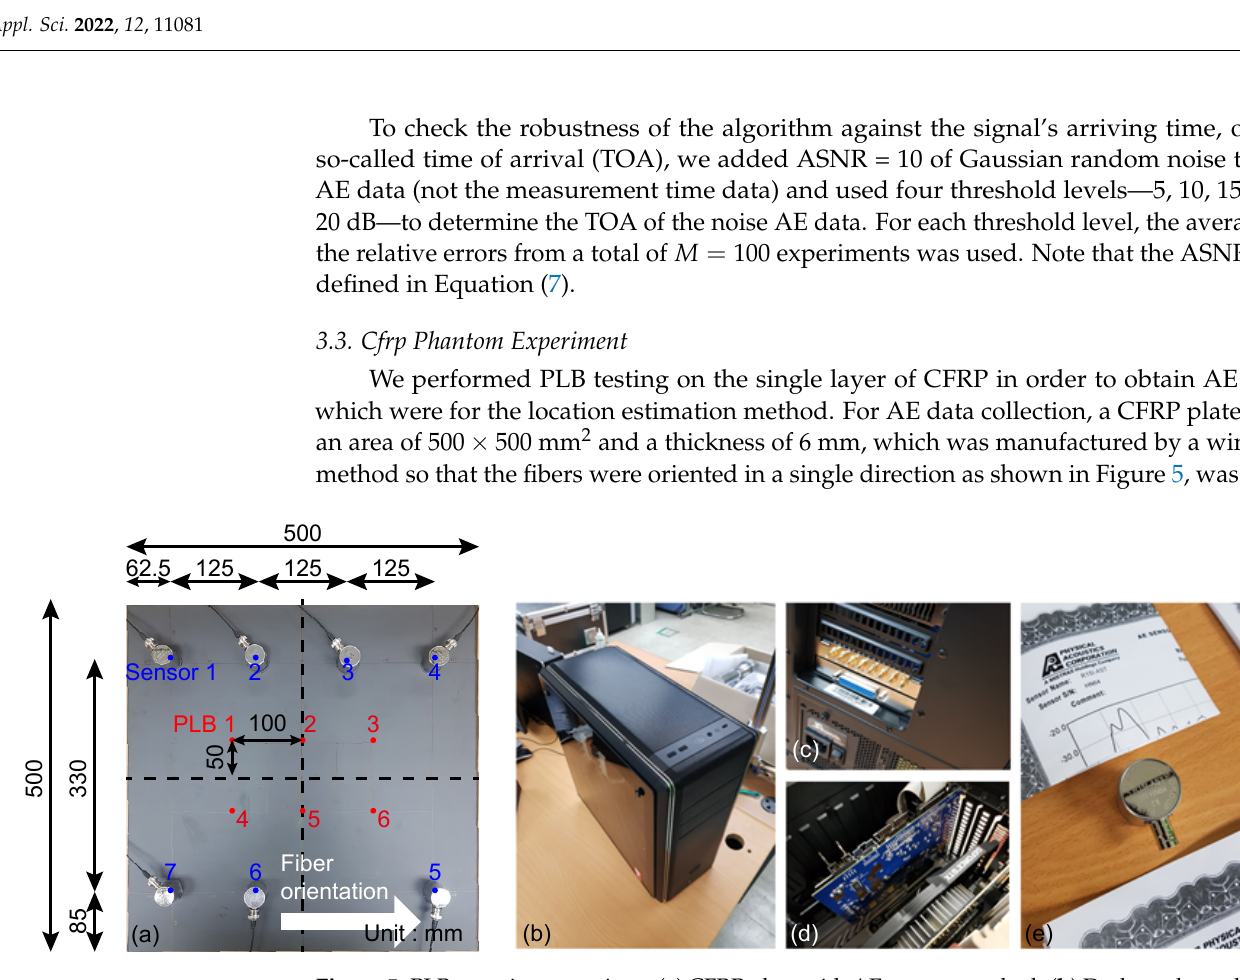
Figure 5. PLB experiment settings. ( a ) CFRP plate with AE sensor attached. ( b ) Desktop that collected AE signals measured by sensors. ( c ) Connector for connecting PAC board and sensor. ( d ) PAC’s Express-8 board. ( e ) PAC’s AE sensor (model: R15i-AST).